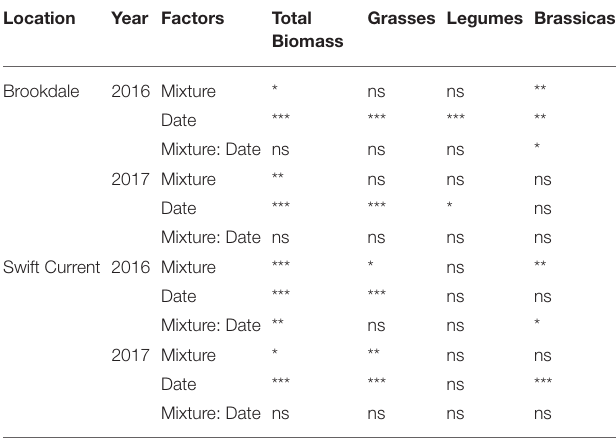
TABLE 1 | ANOVA results of the effect of cropping mixtures (monoculture, three, six, and nine spp.) and date of sampling (mid or late growing season) on total aboveground crop biomass production and of each functional group (grasses, legumes, brassicas) at the Swift Current and Brookdale research sites in 2016 and 2017.